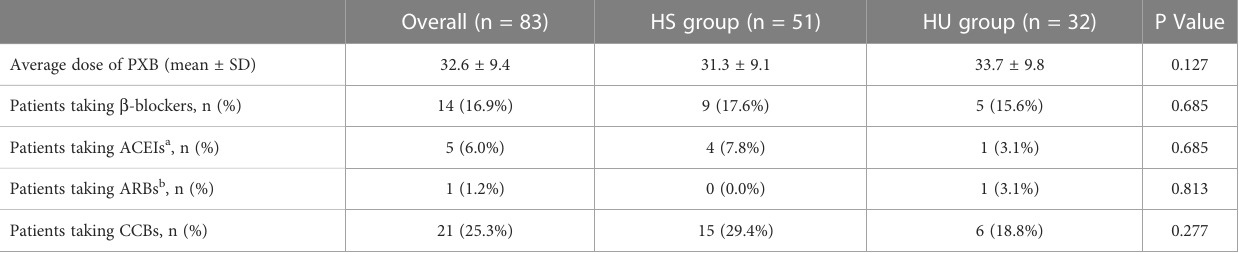
TABLE 2 Preoperative medication for patients with adrenal